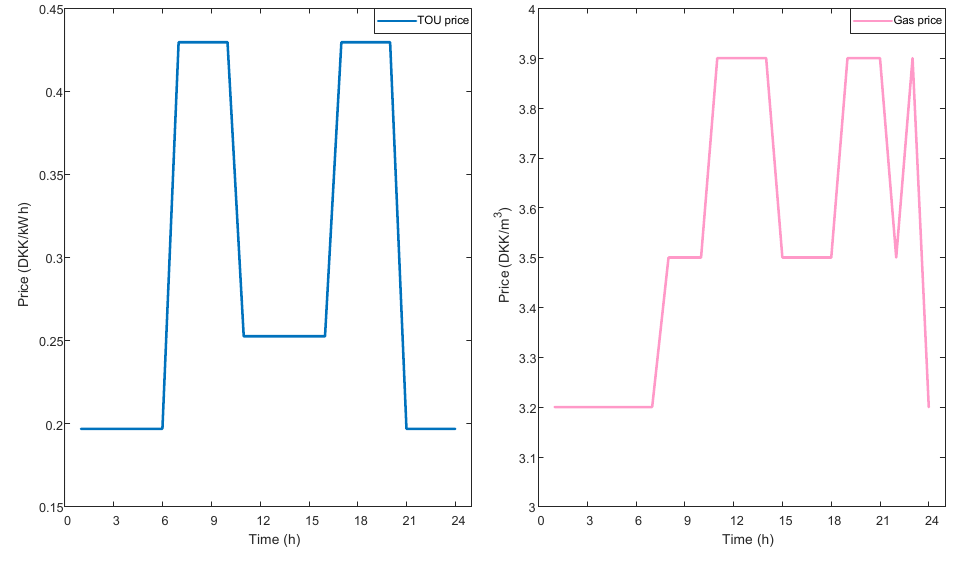
Figure 3. TOU price and gas price.